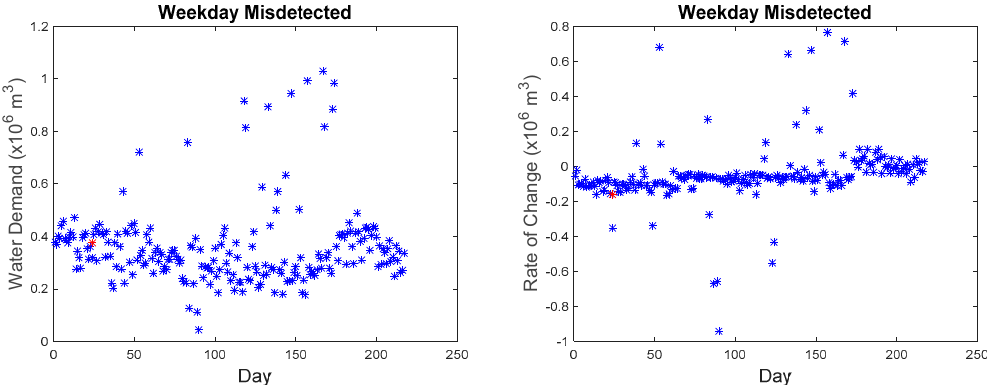
Figure 22. Comparison of fourth missed detected anomaly with other points.